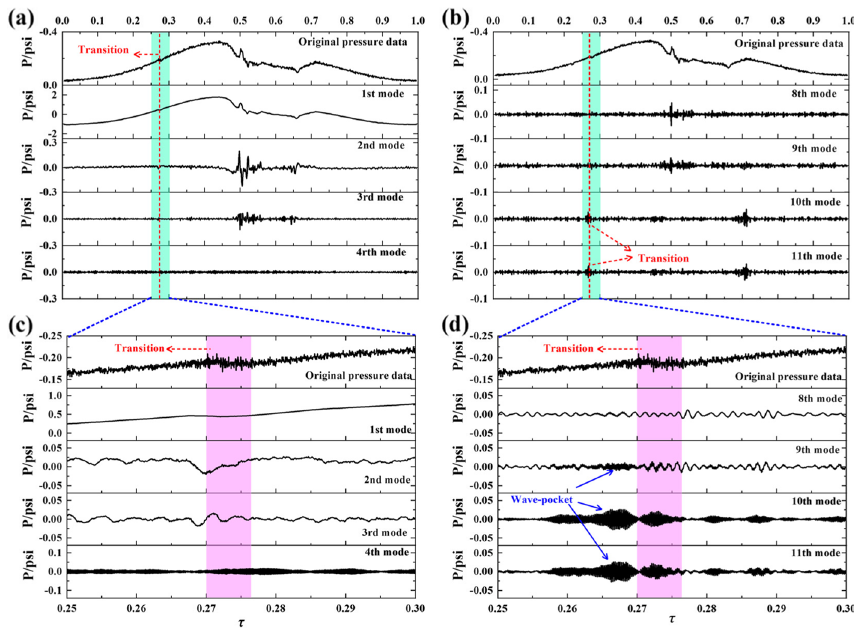
Fig. 9 POD decomposition result. a Global 1st – 4th modes, b global 8th – 11th modes, c local 1st – 4th modes, d local 8th – 11th